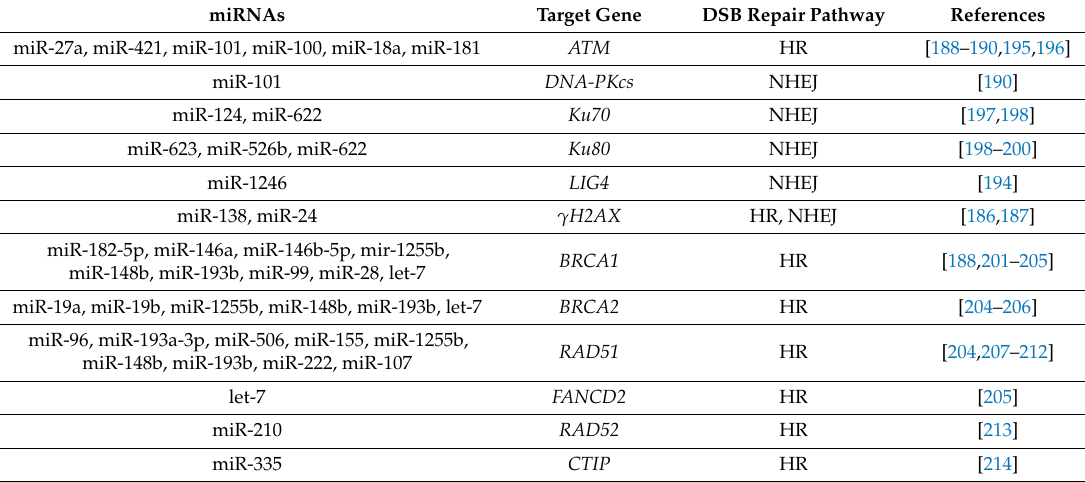
Table 3. miRNAs that directly target genes involved in homologous recombination (HR) or non-homologous end joining